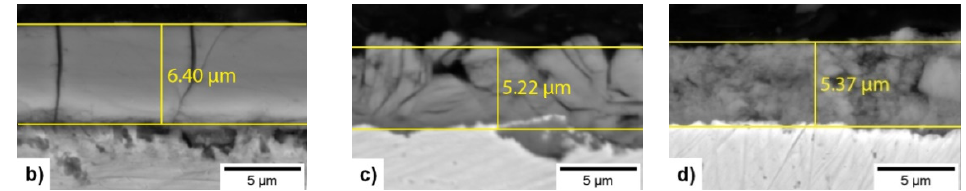
Figure 3. SEM images of the cross-section structure of phosphate coatings obtained in solutions with different GO concentration in the phosphating solution (g/L): 0 ( a ); 0.3 ( b ); 0.6 ( c ) and 1.2 ( d ).